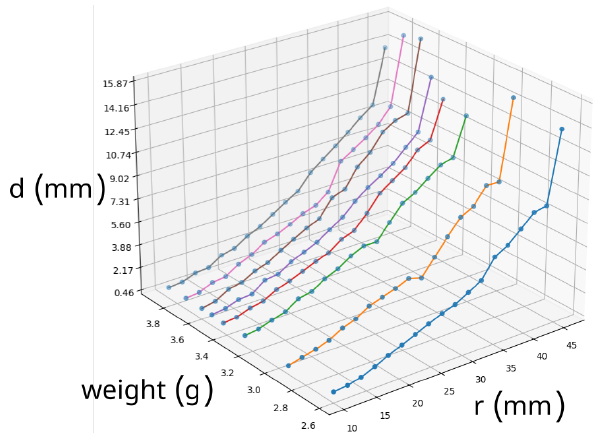
Figure 14. Results from visual analysis. Each line represents the displacement d caused by the particular weight along with the radius r millimeters from the gripper